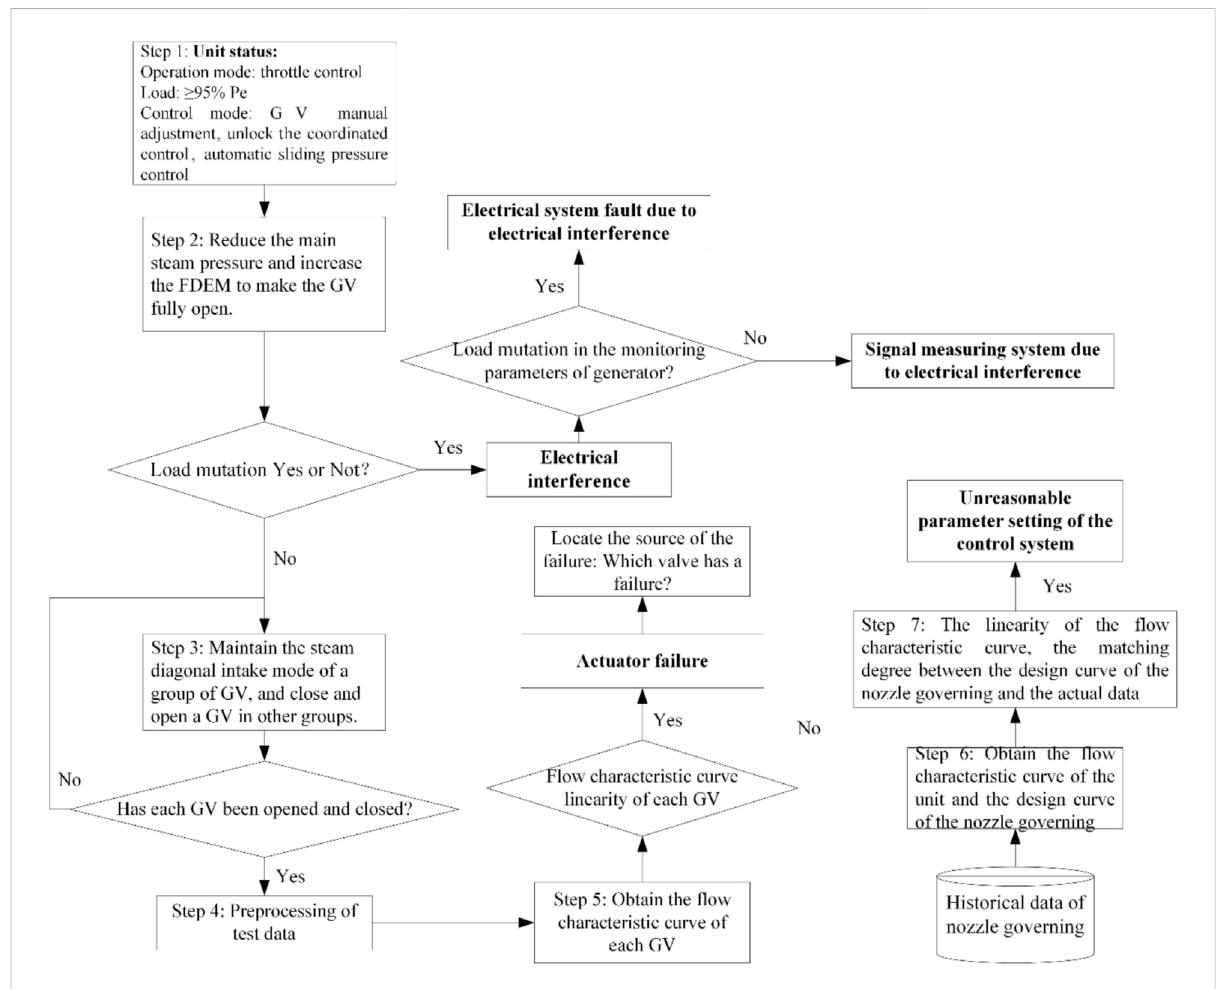
FIGURE 15 Method for load mutation fault diagnosis based on the GV activity